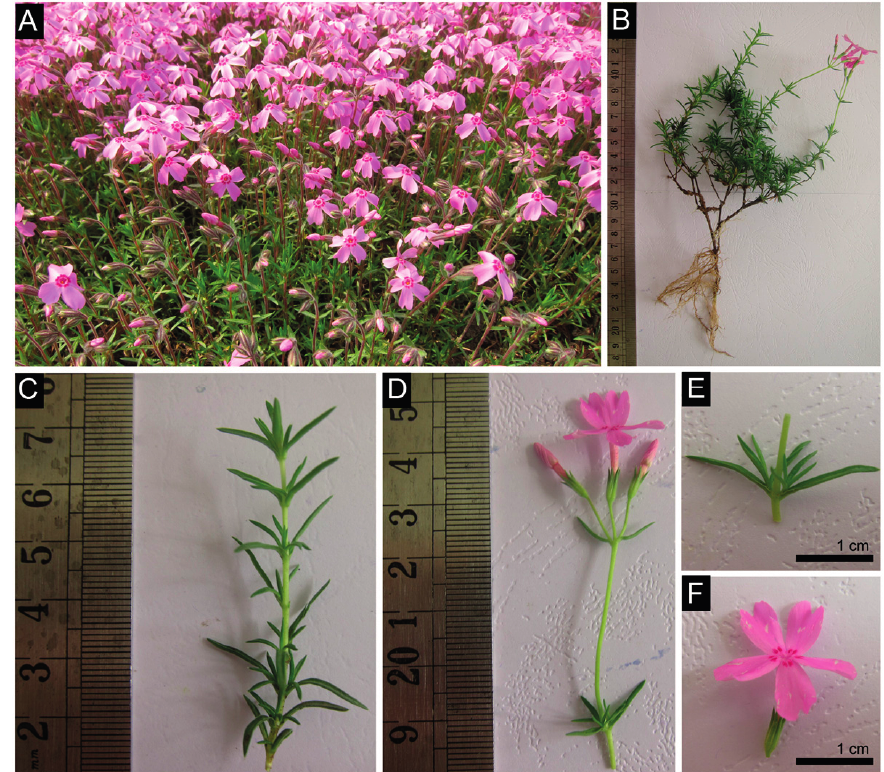
Figure 1. Phenotype characteristics of Phlox subulata. ( A ) Natural populations of P . subulata plants distribution in northeast China; ( B − F ) Phenotypes of the P . subulata plant, and its roots, stems ( B ); leaves ( C , E ); and flowers ( D , F ); Scale bars = 1 cm ( E , F